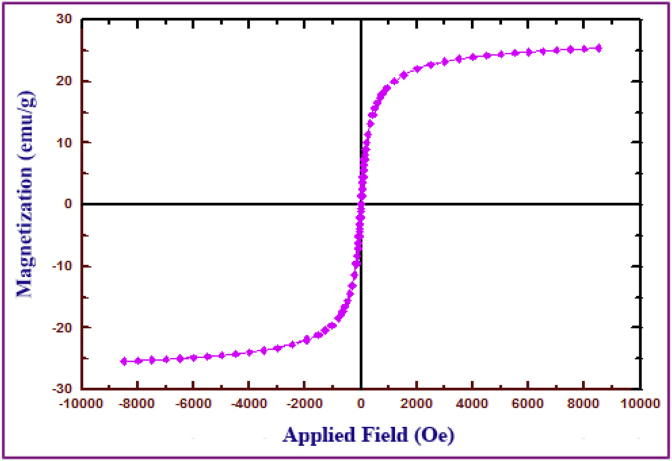
Magnetization curves of Fe3O4@functionalized chitosan nanobiocomposite.